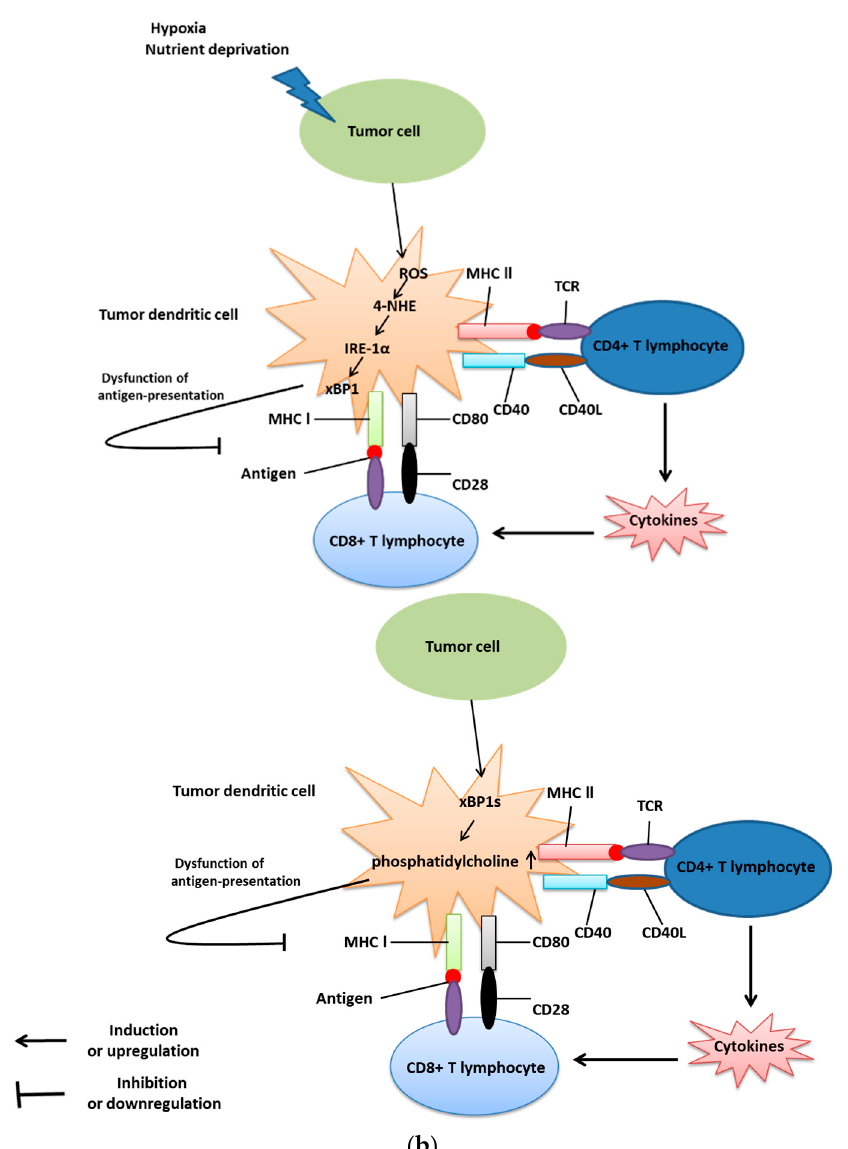
Figure 4. Immunocompetence and immunosuppression. ( a ) Immunocompetence. Dendritic cells (DCs), known as antigen presenting cells, use its CD40 to bind with CD40L (CD40 ligand) on the surface of CD4+ T lymphocyte. Furthermore, DC also uses its MHC-II, combined with antigen, to bind with TCR on CD4+ T lymphocyte. Therefore, CD4+ T lymphocyte is activated by DC to secrete cytokines or to activate B cells. DC can also activate CD8+ T lymphocyte via two signal transductions. One is CD80 and CD28 interaction, and the other is MHC-I and TCR combination; ( b ) Immunosuppression. When the tumor dendritic cell is under stress, such as hypoxia, nutrient deprivation and accumulation of ROS, it activates 4-NHE to induce IRE1- α and its downstream transcription factor, XBP1. This effect leads to the failure of antigen presentation and, therefore, is not able to activate T lymphocytes. Besides, activated XBP1 (sXBP1) can increase the production of phosphatidylcholine, which inhibits the ability of antigen presentation. Redrawn from Cubillos-Ruiz et al. [32].